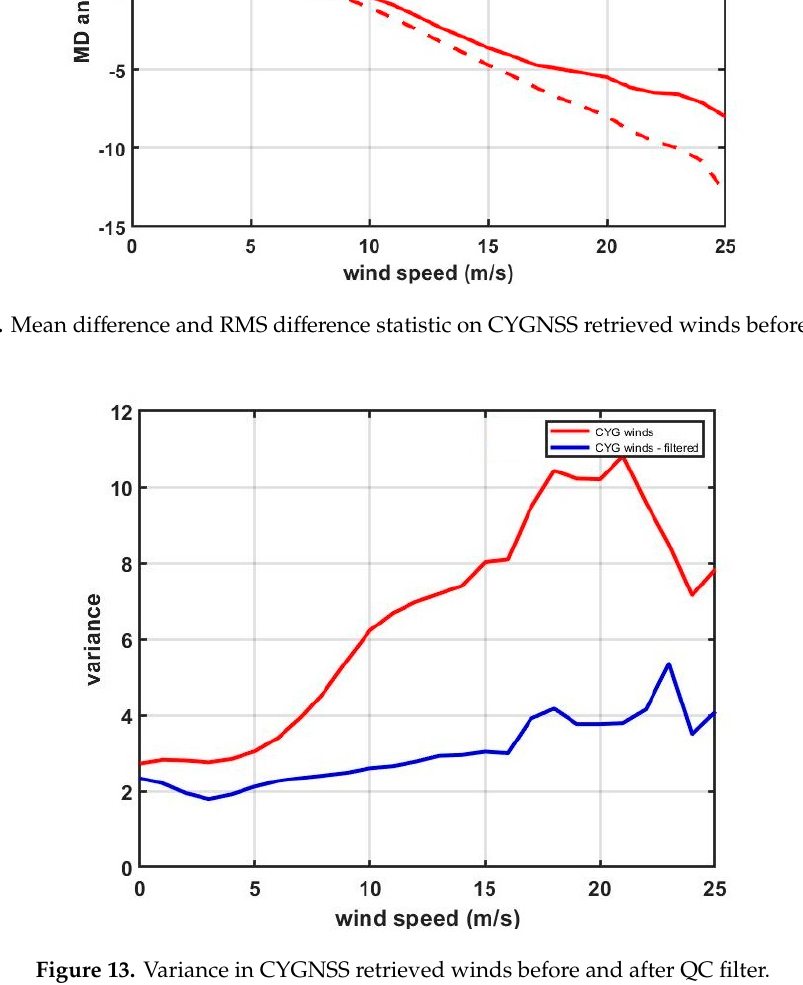
Figure 13. Variance in CYGNSS retrieved winds before and after QC filter.